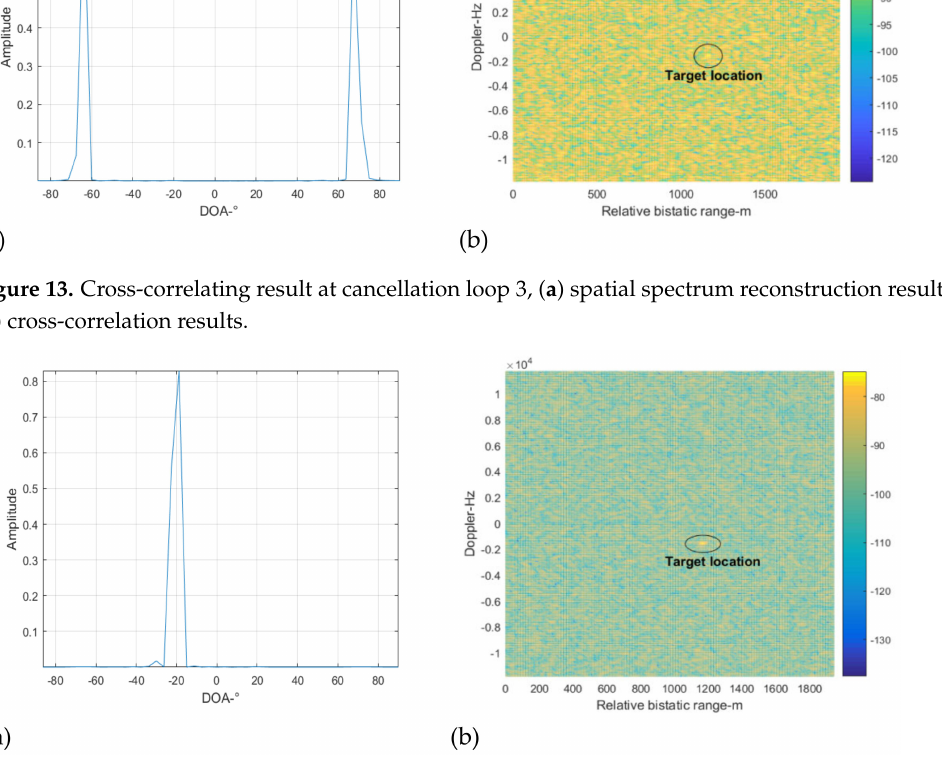
Figure 14. Cross-correlating result at cancellation loop 4, ( a ) spatial spectrum reconstruction results, ( b ) cross-correlation